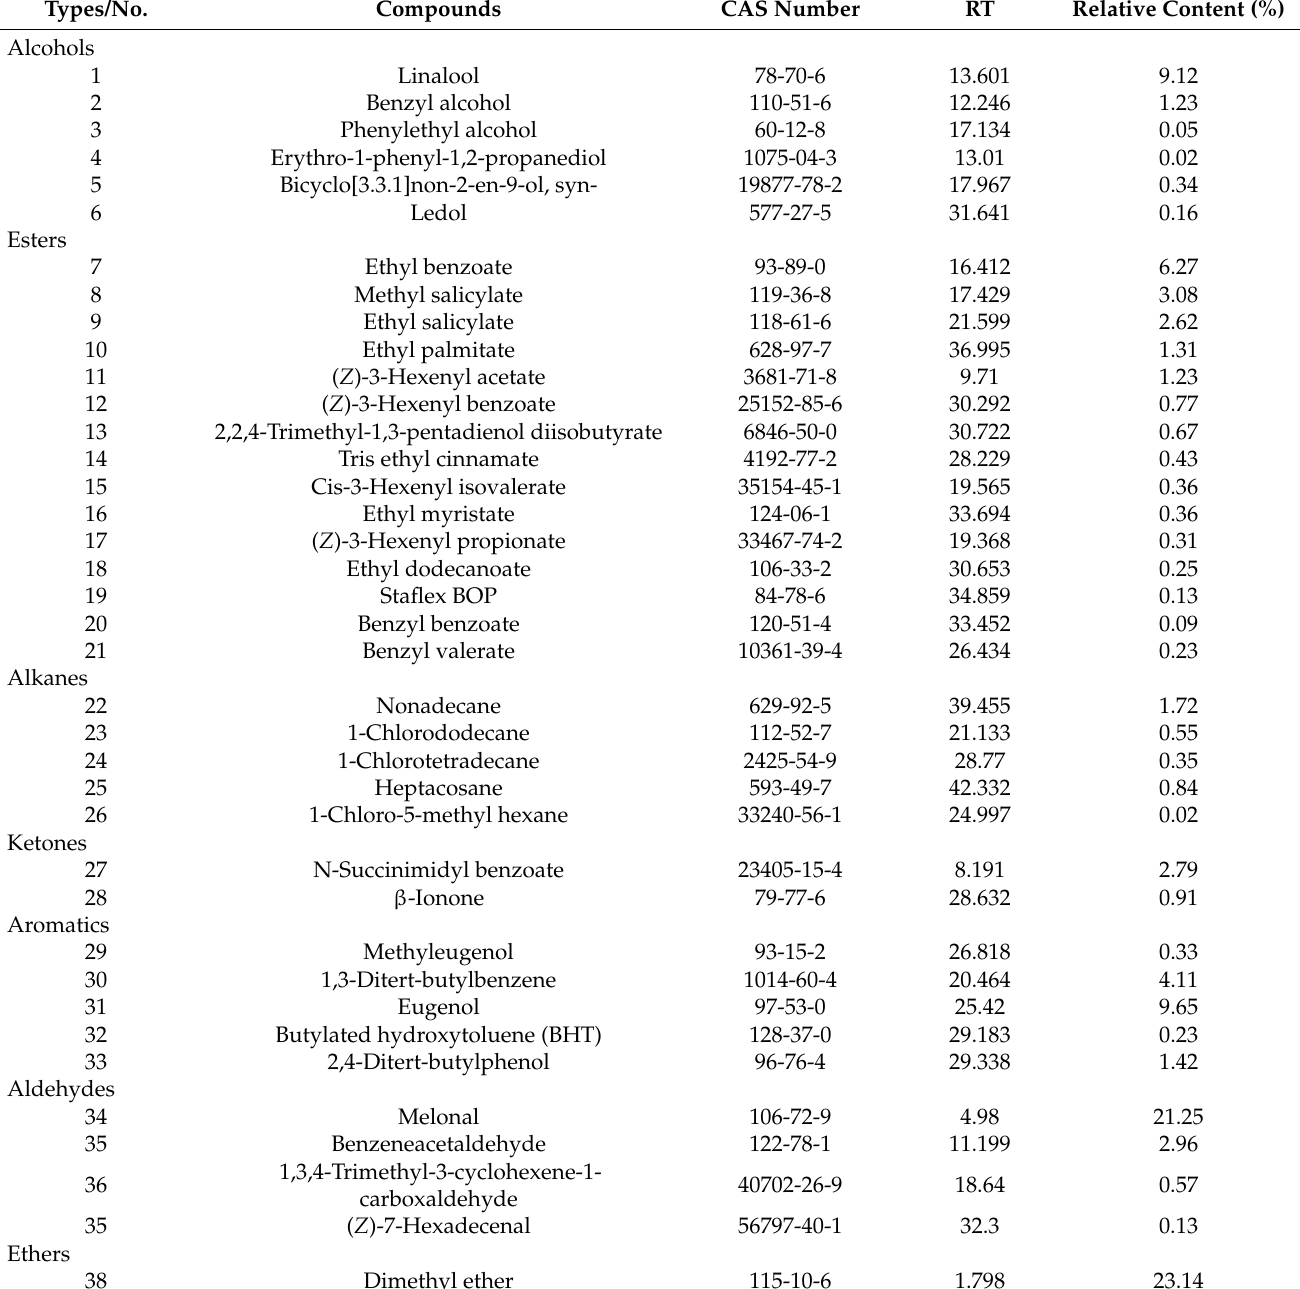
Table 2. Number and relative content (% of each compound) of the compounds identified in ‘Red Face’ flower